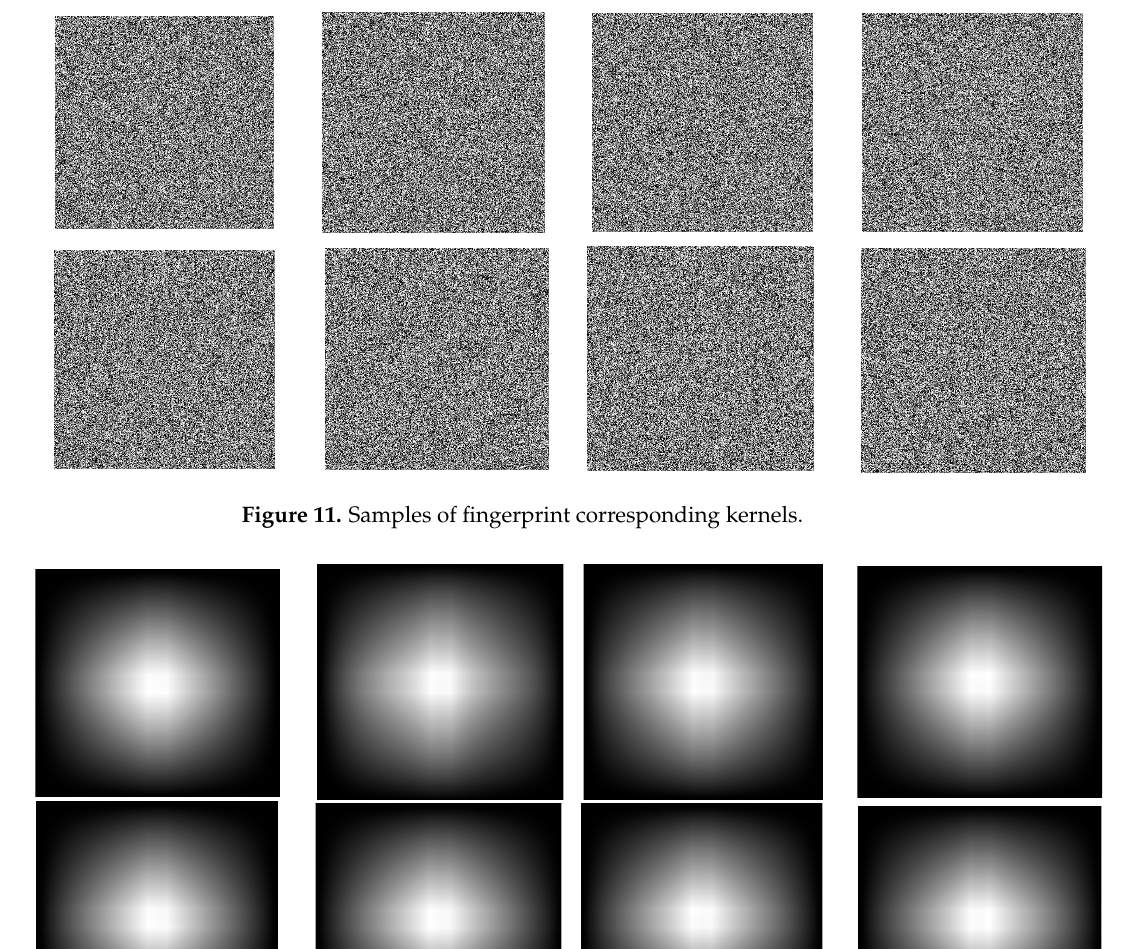
Figure 10. Fingerprint database samples.